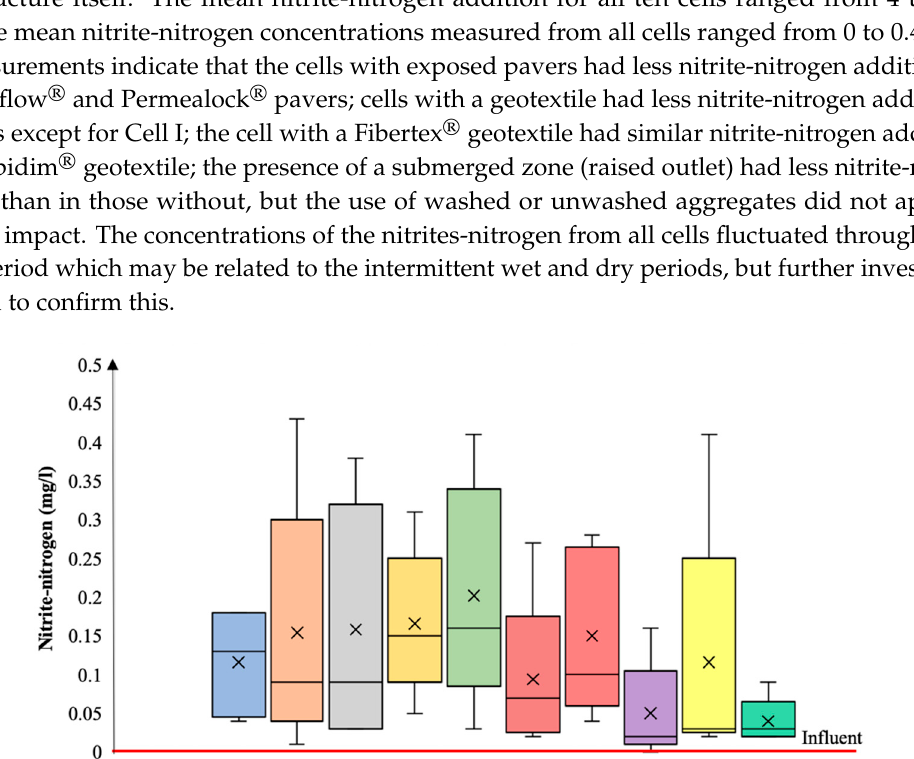
Figure 7. Variation in the ammonia-nitrogen concentrations with time.